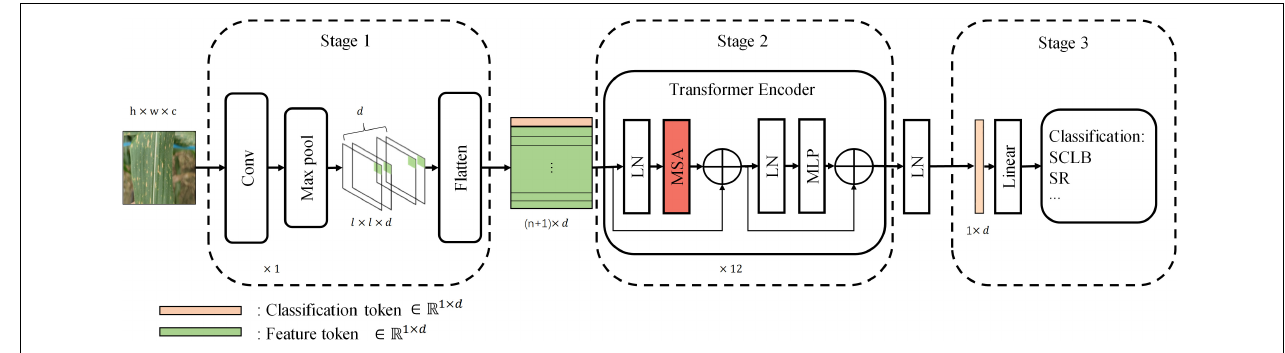
FIGURE 3 | The standard model architecture. Stage 1 extracts information from local regions of the image and encodes them into tokens. Stage 2 is the core computational network that performs the self-attention. Stage 3 maps the classification token into four classes to complete the final classification. Linear, linear layer; LN, layer normalization; MLP, multilayer